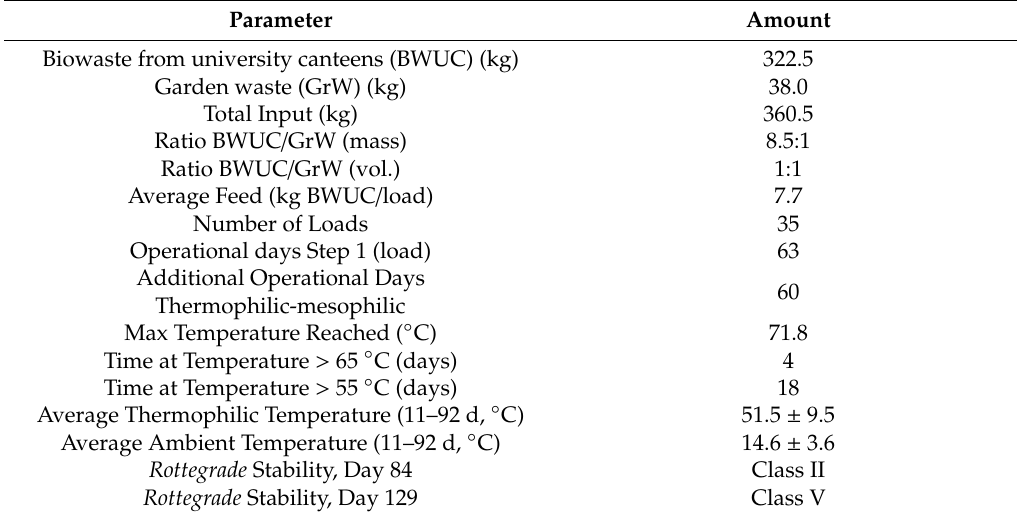
Table 3. Operational characteristics of the second composting batch in the Philology Faculty.